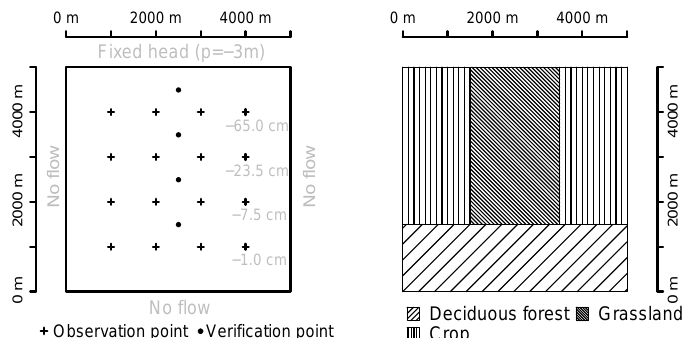
Figure 5. Synthetic set-up for the twin experiment. The left hand figure shows boundary conditions of the subsurface model (ParFlow) and the location of observation (crosses) and verification (filled circles) points. Grey numbers indicate the depth of observation and verification nodes, which are constant in west–east direction. The right hand figure shows the spatial distribution of plant functional types used in the land surface model